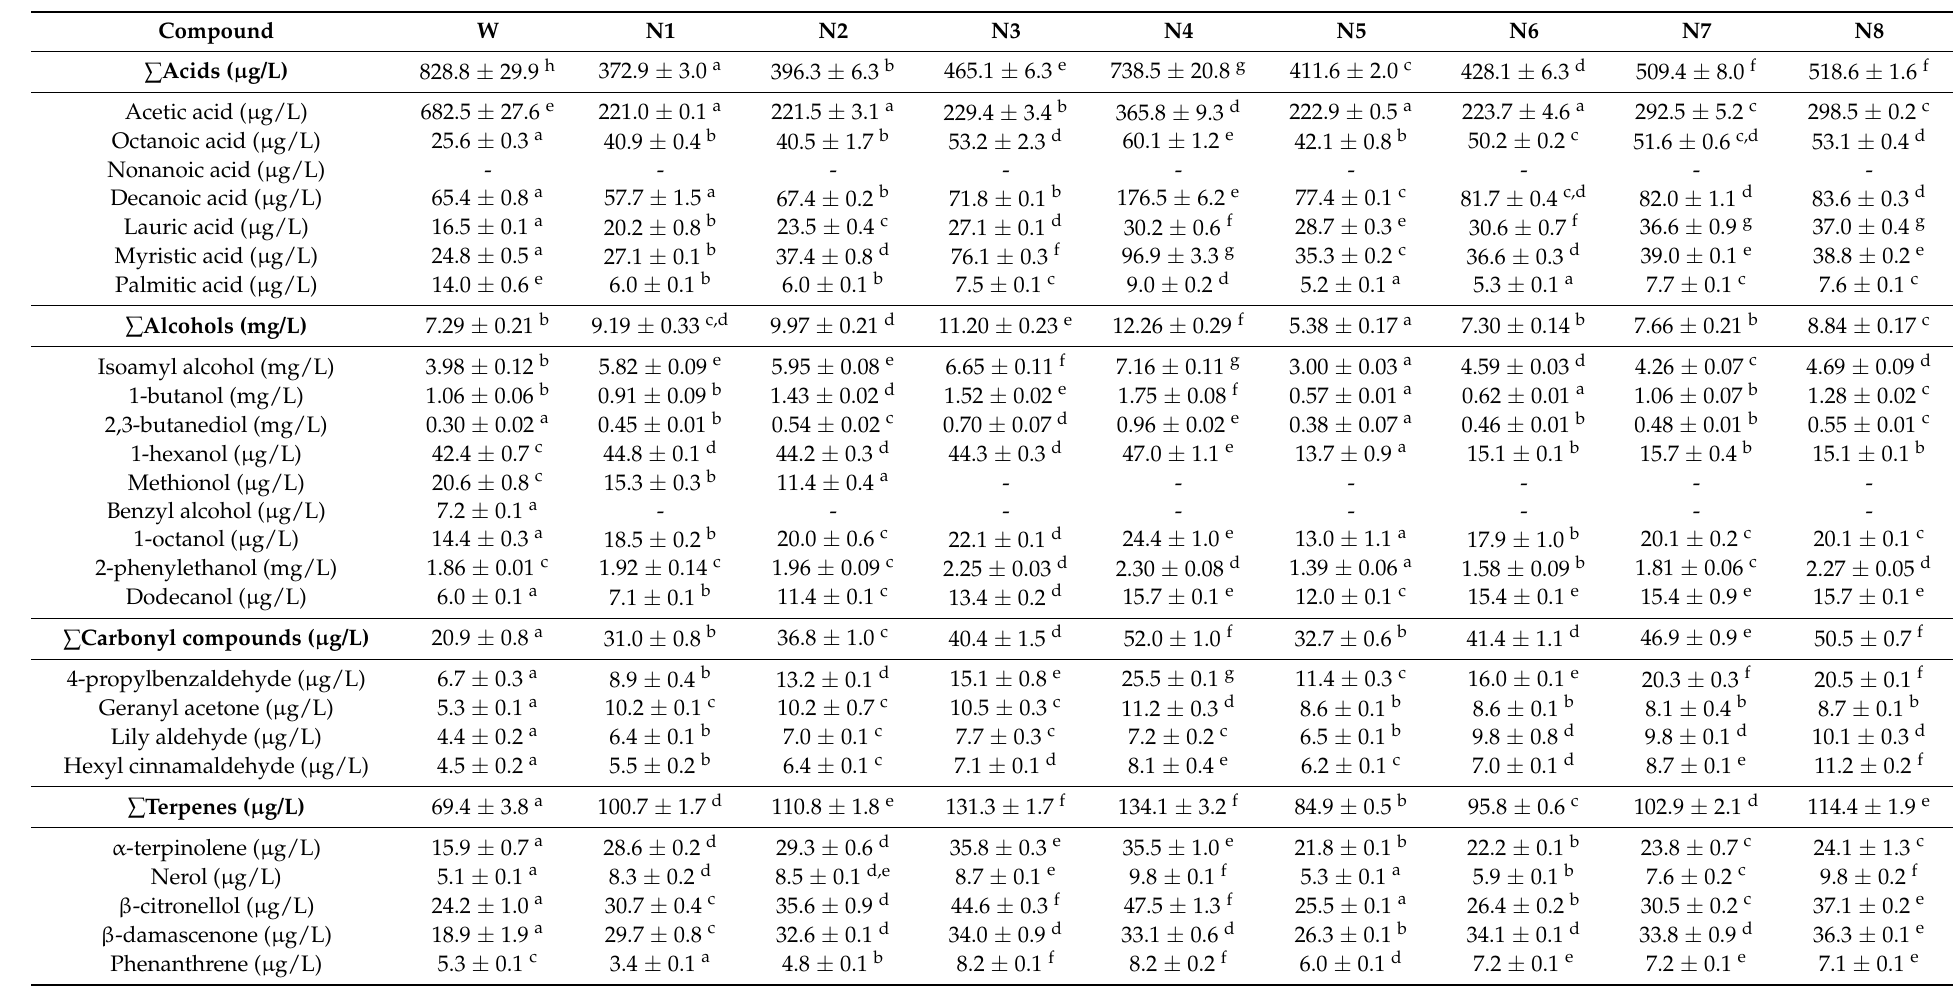
Table 5. Aroma compounds identified in Cabernet Sauvignon red wine and nanofiltration retentates at 2.5, 3.5, 4.5 and 5.5 MPa with cooling and without cooling.